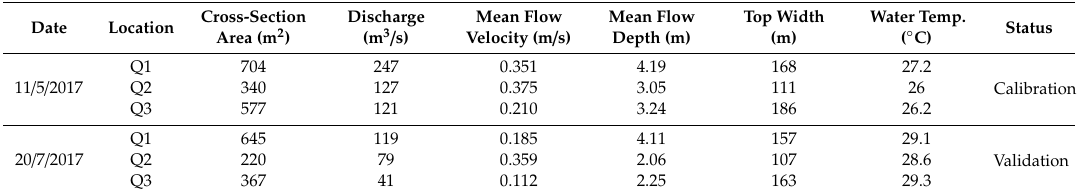
Table 2. Summary of the field